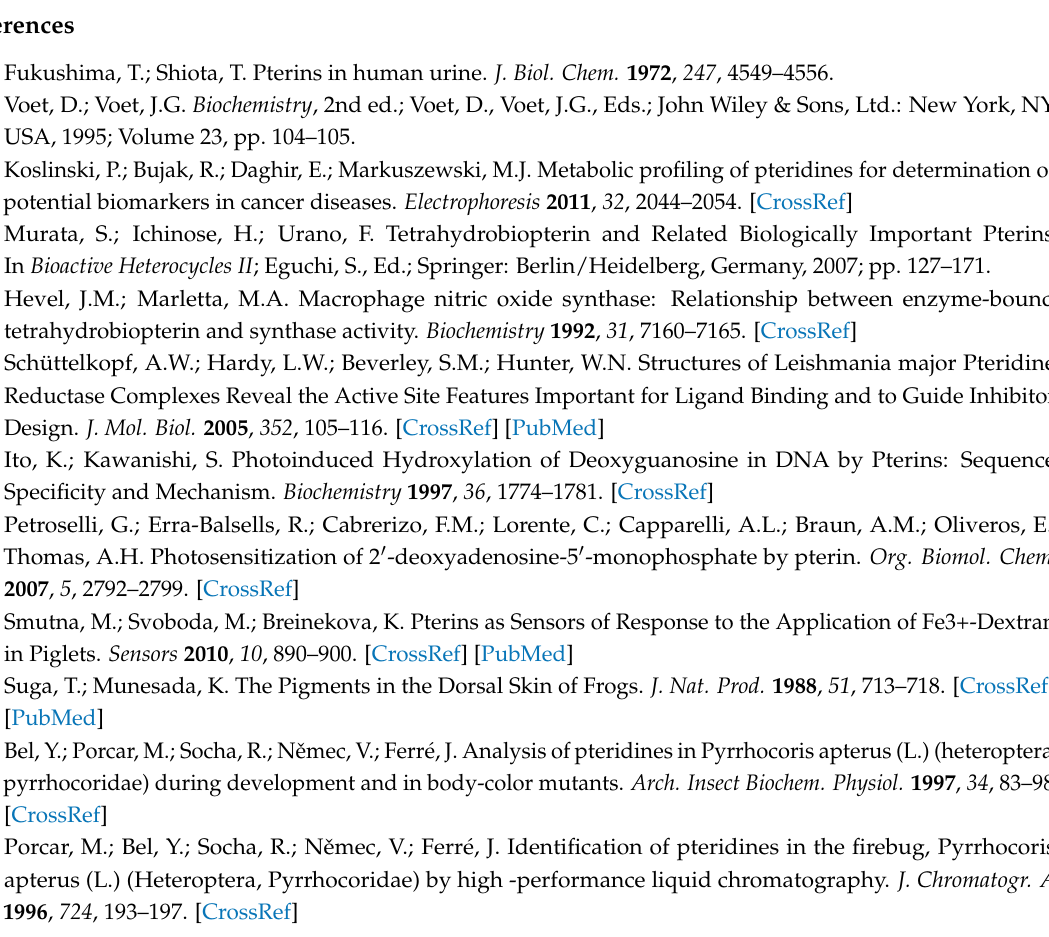
Supplementary Materials: The following are available online. Figure S1: UV absorbance spectra for the selected